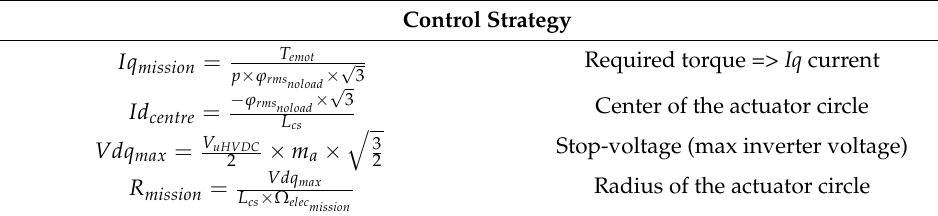
Table 8. Initialization of the actuator control strategy.